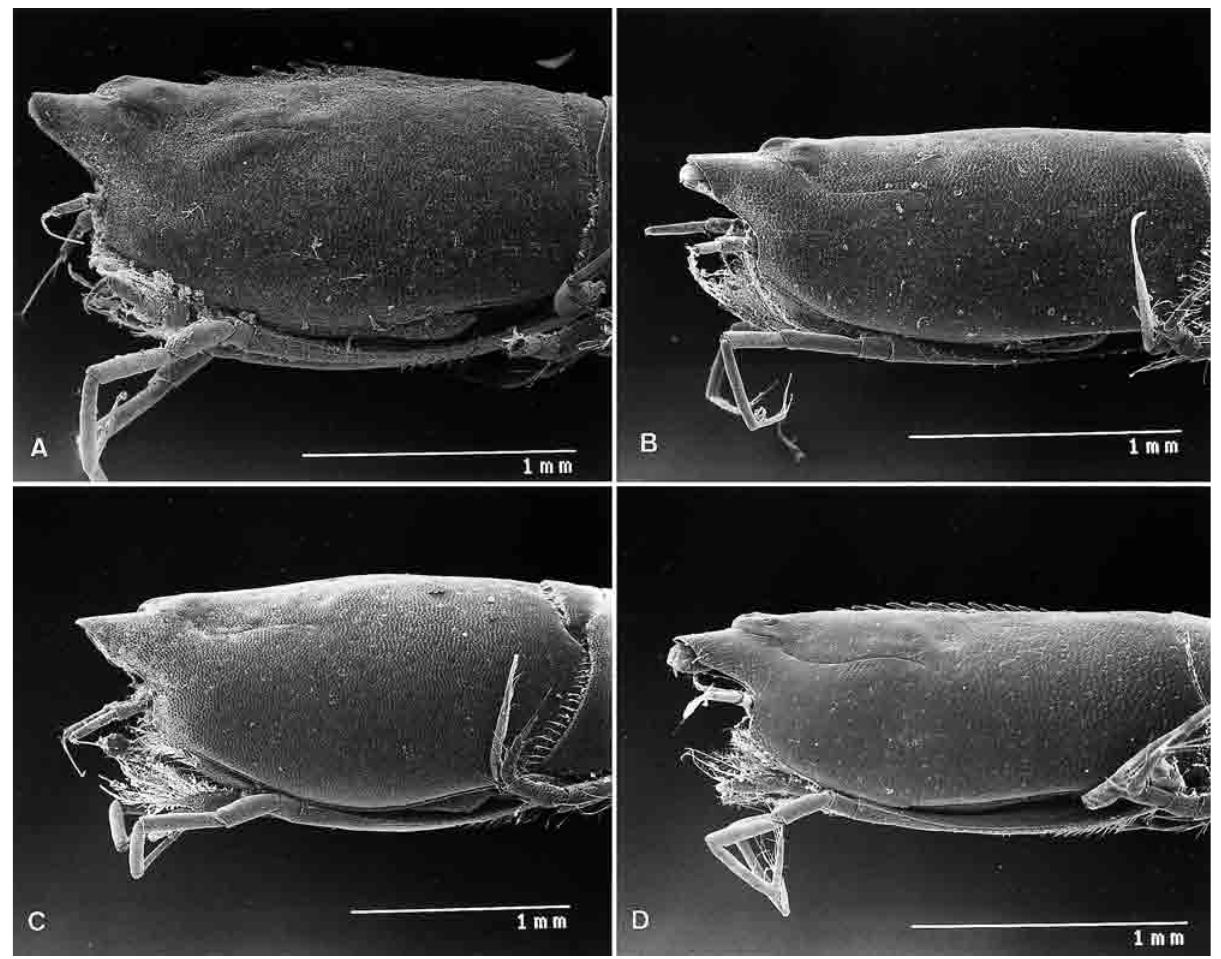
Remarks : the total length of male adults varies between 6.5 mm and 9.2 mm with the carapace (Fig. 4b) representing a quarter (0.238) of the total length excluding the uropods. The mean length to height ratio is 2.2 (Table 2). Iphinoe douniae is closely related to I. trispinosa (Goodsir, 1843); adult males of both species have an unarmed dor- sal edge of the carapace, a single aesthetasc in the terminal article of the first antenna, a sternal process (Fig. 5A) and a pair of perianal setae. They differ, however, in that I. douniae has plumose setae in the carpus of the second pereo- pod and a longer